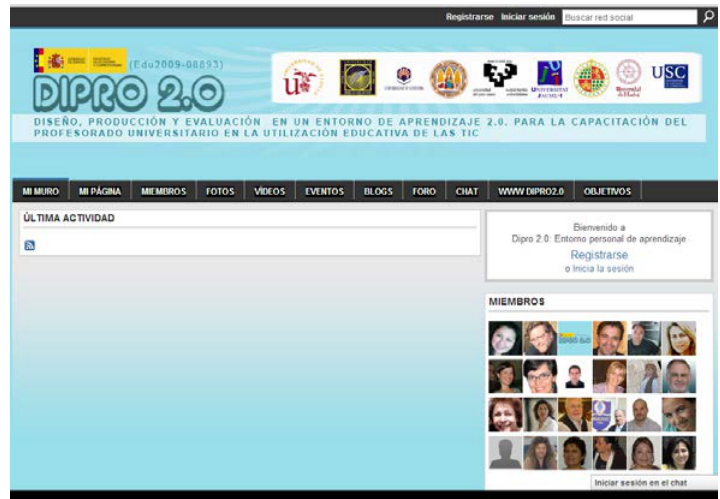
Figure 1 . Gate of DIPRO 2.0 (see http://dipro20.ning.com/).